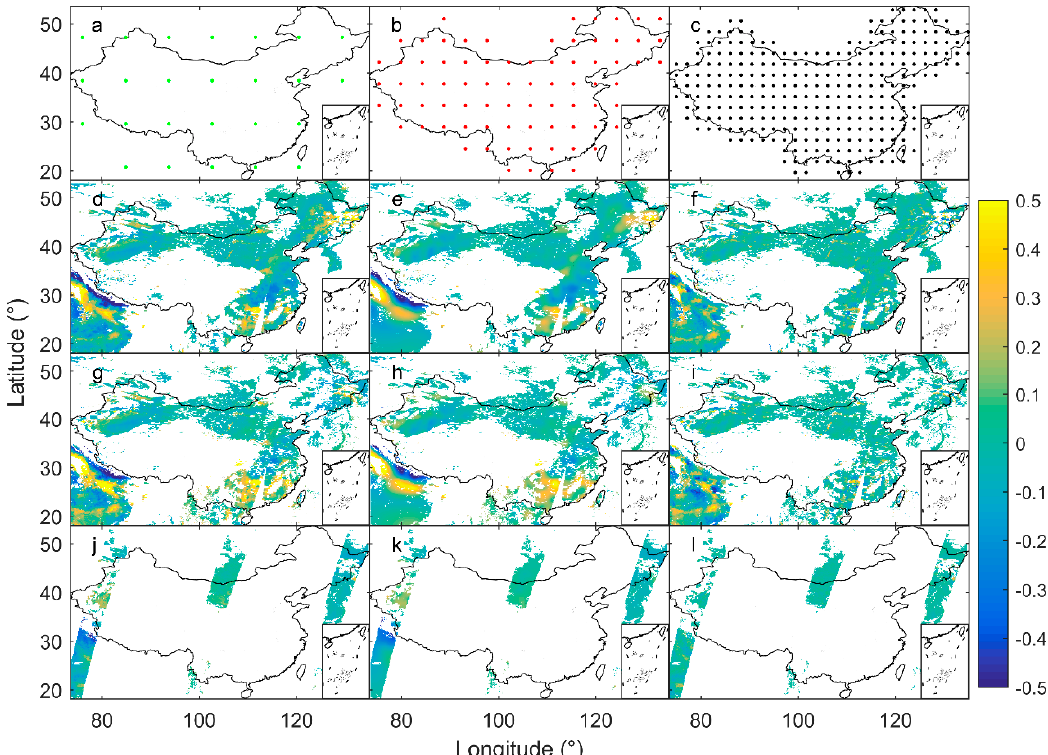
Figure 4. An example of fitting effects with spatial bases under three resolutions in 2017-10-30. Subgraphs ( a ), ( b ), and ( c ) show the spatial base center point locations for the first, second, and third resolution, respectively. Subgraphs ( d ), ( g ), and ( j ) show the detrended DB AOD, detrended DT_DB_Combined AOD, and detrended MISR AOD, respectively. Subgraphs ( e ), ( h ), and ( k ) show the fitting effects with spatial bases under three resolutions, respectively. Subgraphs ( f ), ( i ), and ( l ) are the corresponding residuals, respectively. Table 1. Parameters of fitted spherical models for randomly chosen 10 days’ AOD products with better spatial